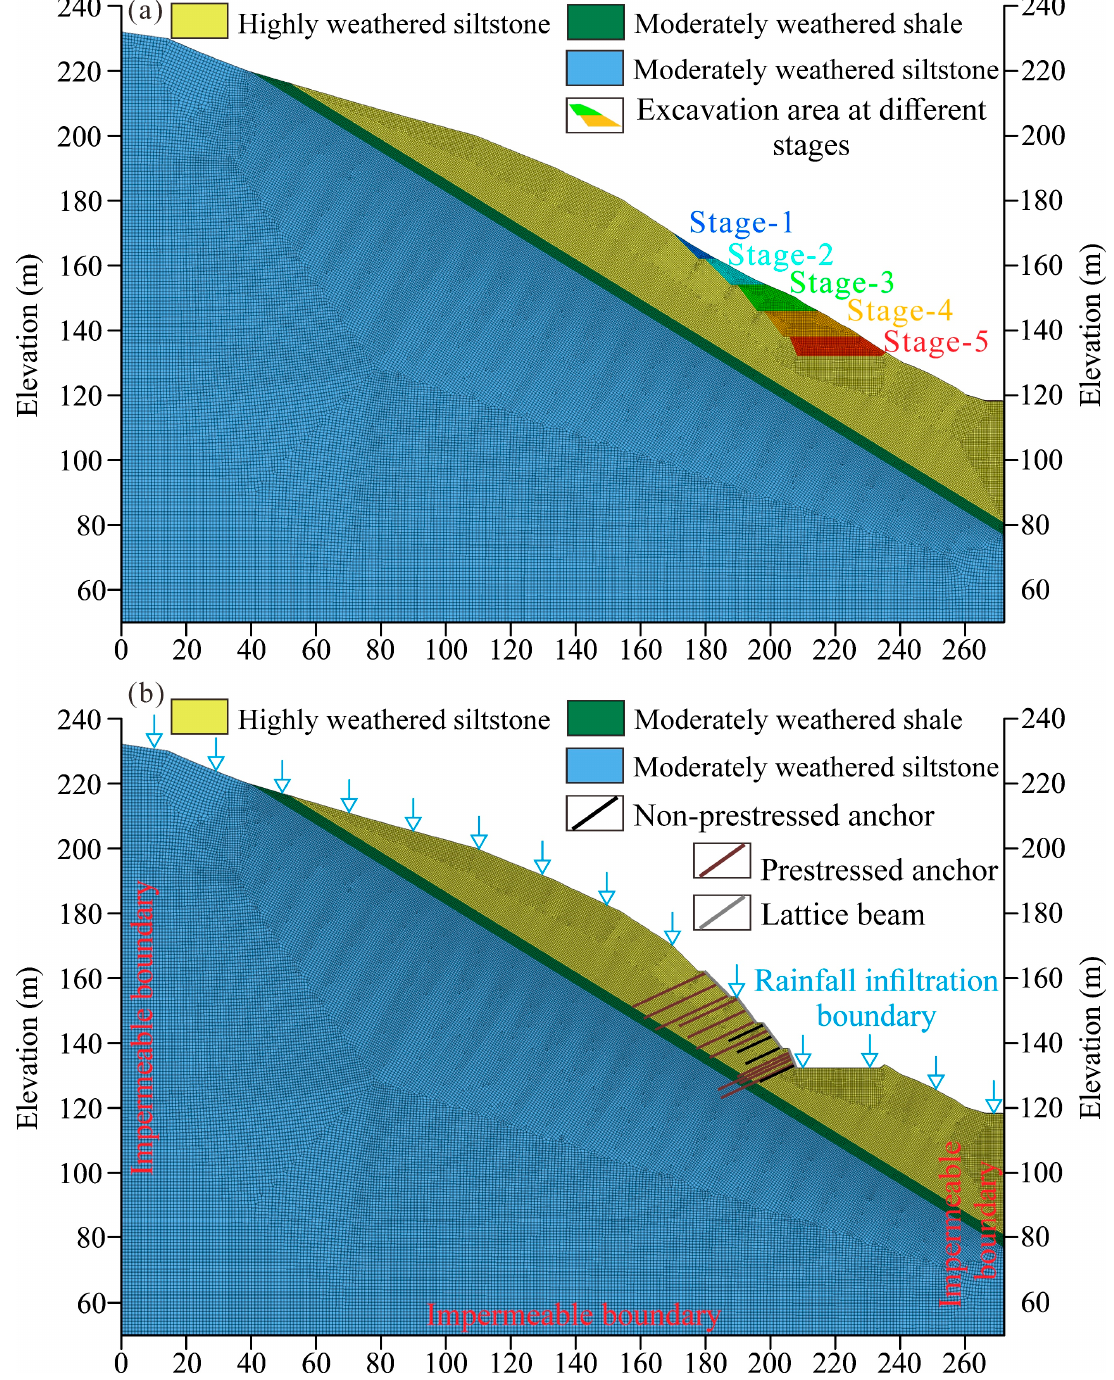
Figure 7. 2D numerical model of section 1-1 ′ . ( a ) Numerical model under natural conditions during construction. ( b ) Numerical model under extreme rainfall conditions.